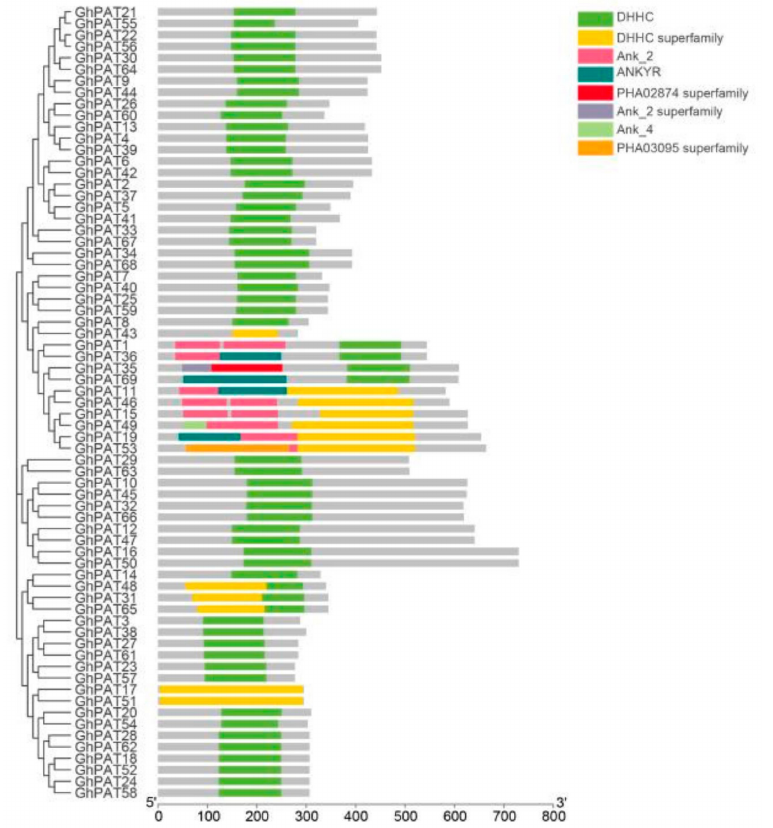
Figure 4. Structural domain analysis of genes that are members of the GhPAT family. Predicting cis-acting elements can infer the possible functions of proteins encoded by downstream genes, and these elements are distributed differently in different genes (Table S2). These distribution patterns indicate that the induction of light, stress, growth, devel- opment, and hormones by these genes can have important effects (Figure 5). Analysis of 69 GhPAT elements showed that there are a large number of core elements in their promoter regions (Figure 5), including TATA-box and light-responsive elements (AE-box, MRE, Sp1, etc.). More cis-responsive elements related to hormones, such as abscisic acid (ABREE), auxin (TGA-element, AuxRR-core), and methyl jasmonate (GA-motif, GARE-motif), were relatively abundant. Most are related to stress, such as drought (MBS, MYB), low tempera- ture (LTR), anaerobic induction (ARE), hypoxia induction and defense and stress response (TC-enriched repeats). There are also cis-elements related to phloem organization (CAT-box, CCGTCC-box, OCT), and some genes contain genes related to zein metabolism (O2-site). This finding fully indicates that GhPATs are involved in the stress response process brought about by plant growth and development and environmental